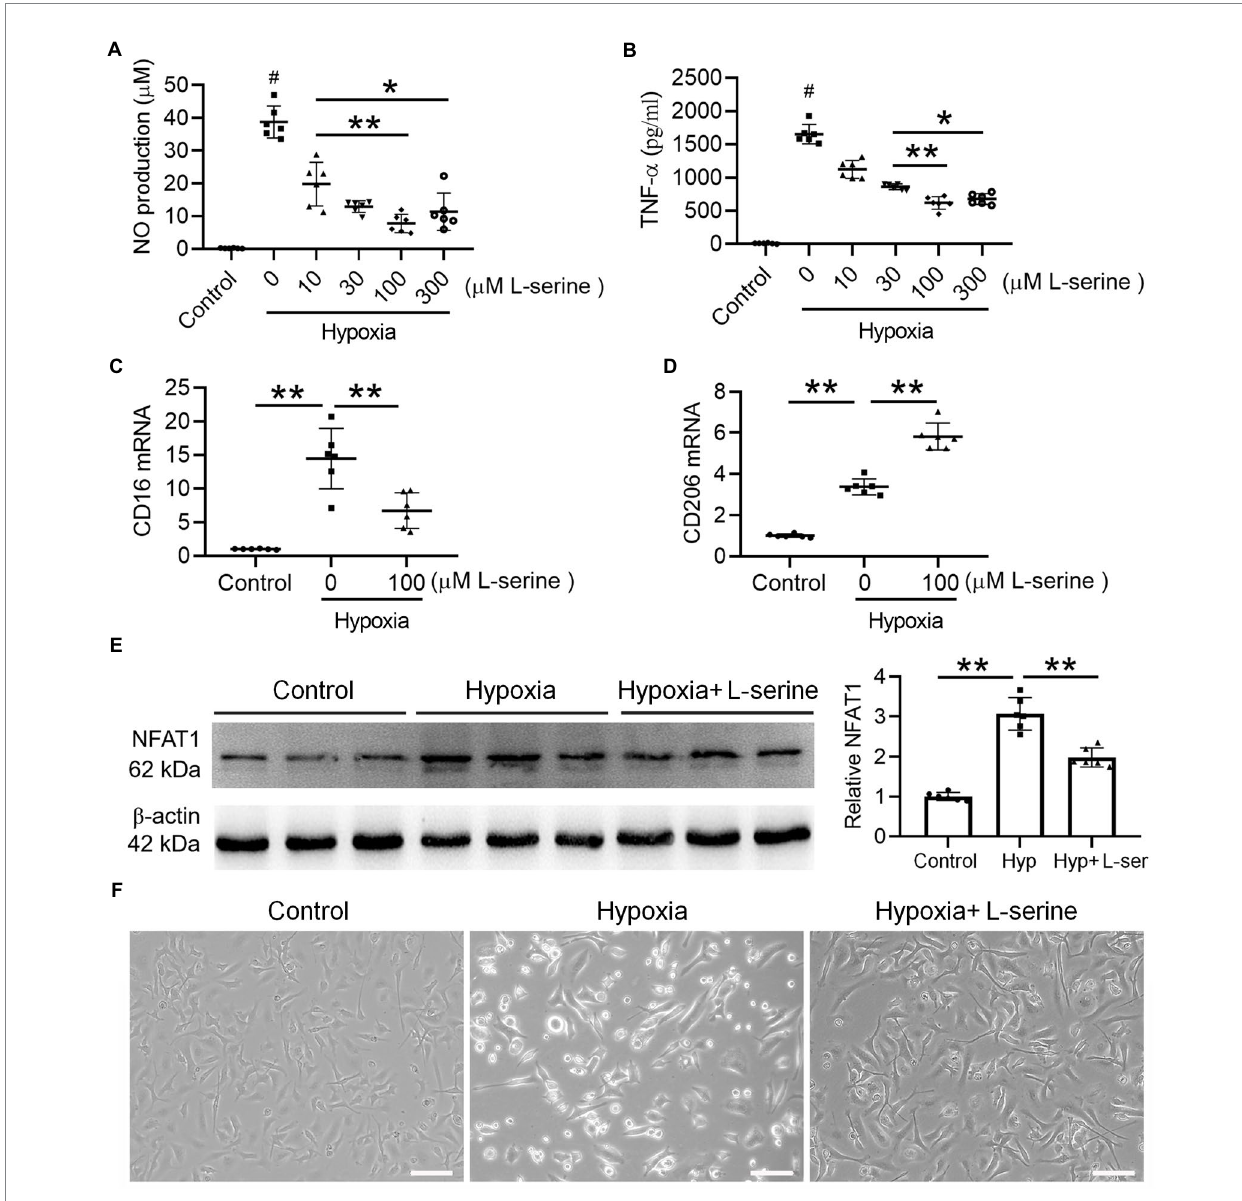
FIGURE 6 Effects of L-serine on inflammatory mediators, NFAT1 expression and microglial polarization after hypoxia treatment in vitro . (A,B) Levels of NO and TNF- α in LPS-treated microglia with or without different concentrations of L-serine. (C,D) Messenger RNA levels of CD16 and CD206 in cultured microglia after treatment with hypoxia in vitro with or without L-serine. (E) Protein expression levels of NFAT1 detected by Western blot in cultured microglia after treatment with hypoxia in vitro with or without L-serine. (F) Photomicrographs showing the morphology of mouse primary microglia in the three groups. n = 8–10. * p < 0.05, ** p < 0.01 versus the indicated group; # p < 0.01 versus other